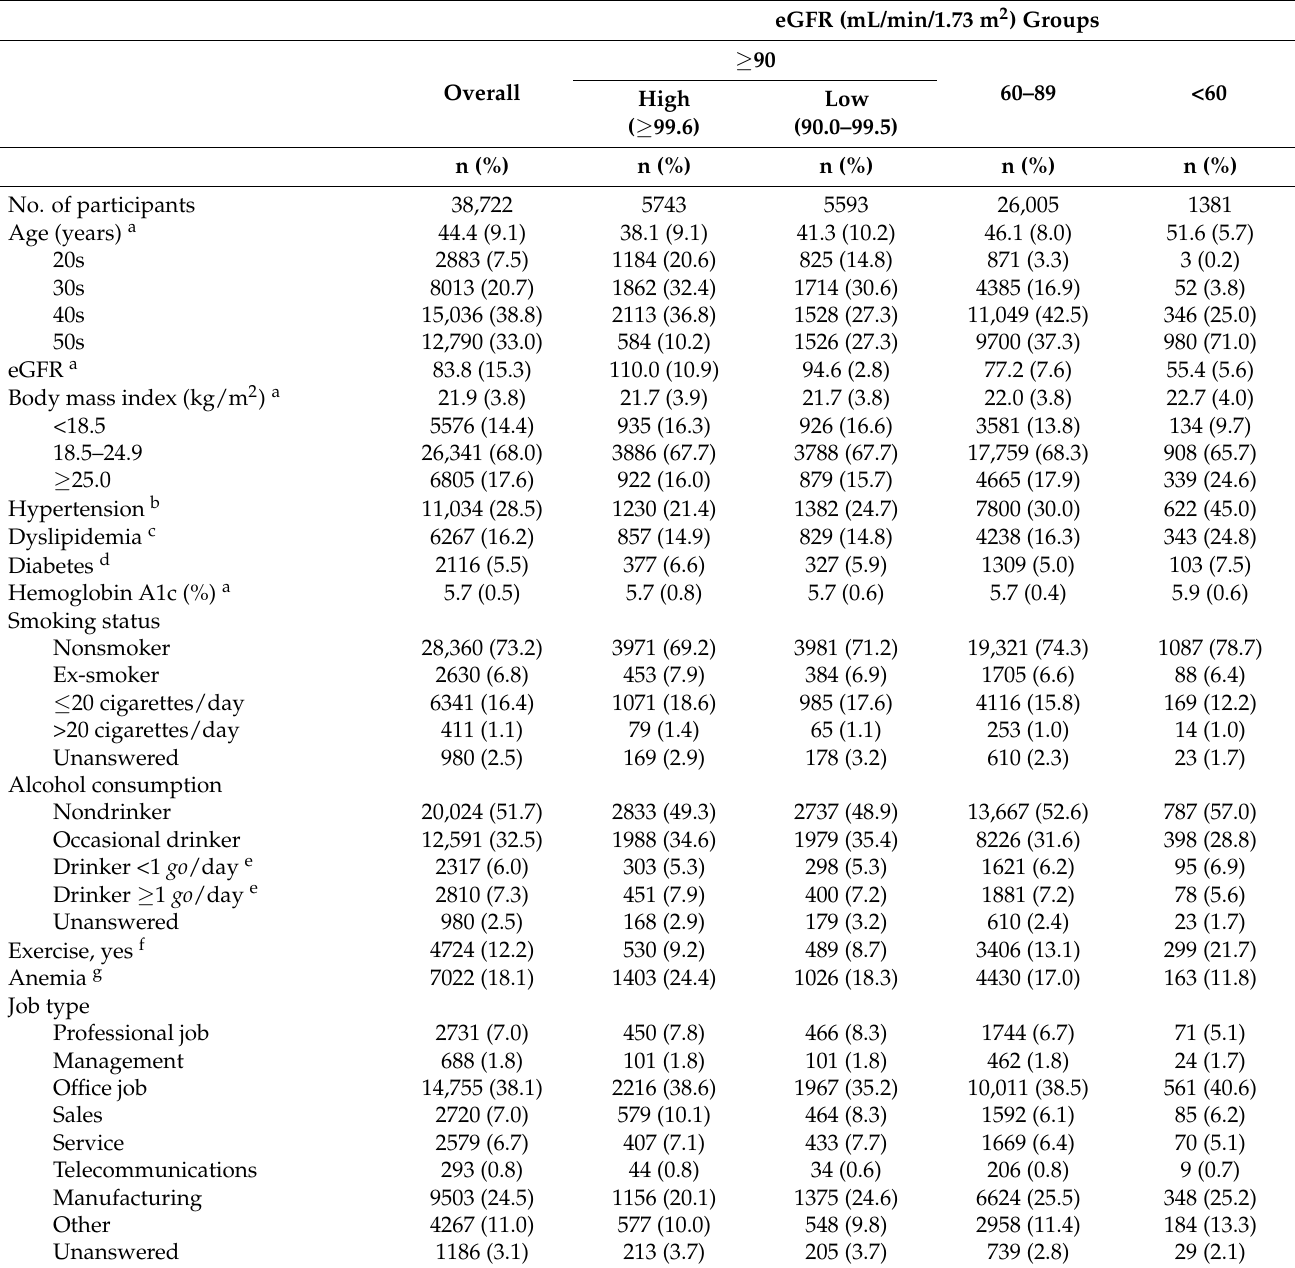
Table 2. Baseline characteristics according to estimated glomerular filtration rate groups in female